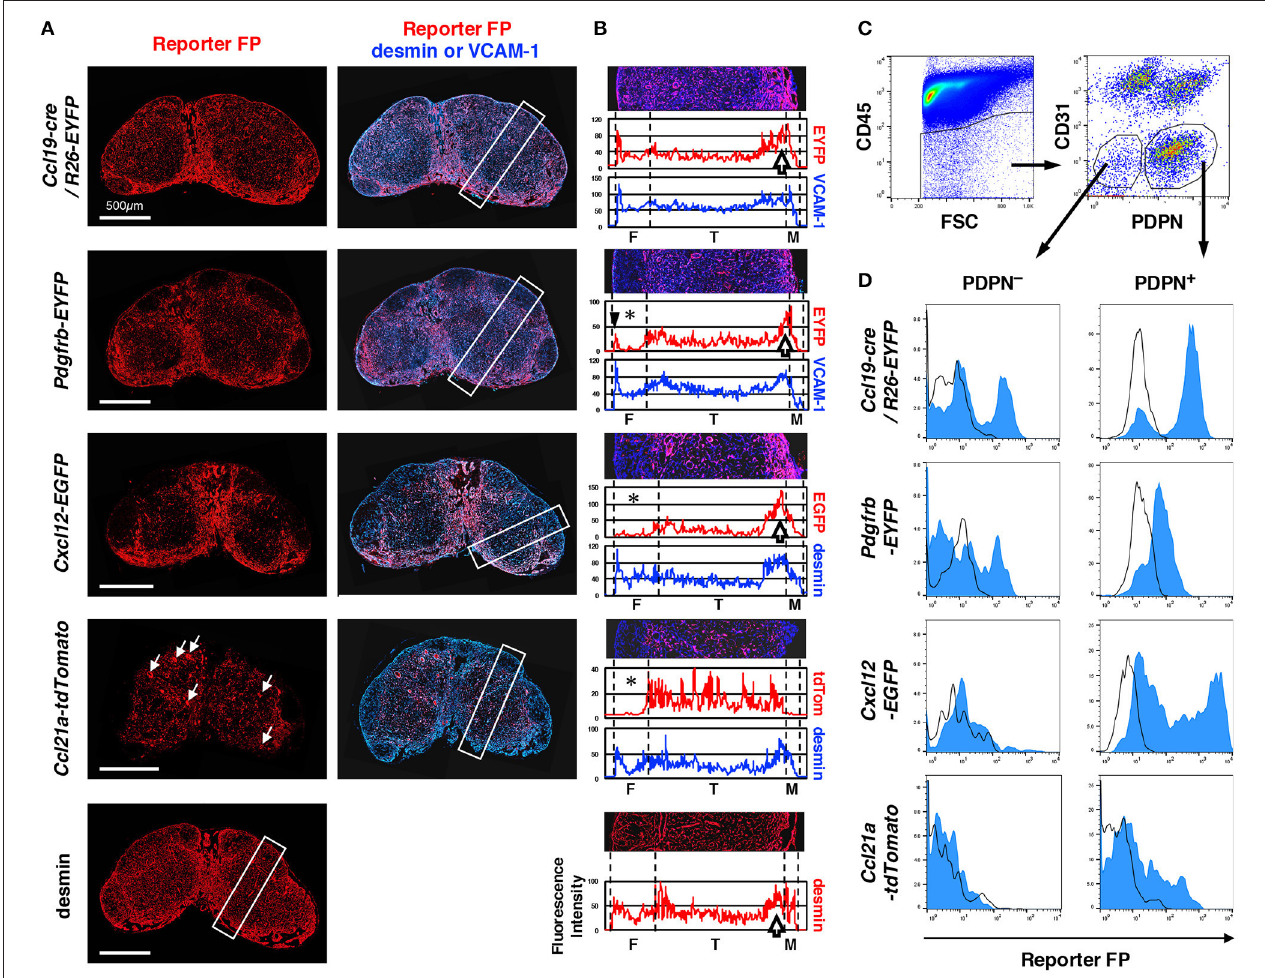
FIGURE 1 | Differences in LN stromal structural patterns based on gene reporters. (A) Whole views of inguinal LNs isolated from various reporter mice. Vertical sections of LNs were stained with antibodies against fluorescent protein (FP) and desmin or VCAM-1. White arrows in the panel of Ccl21a -tdTomato indicate HEVs. (B) Average fluorescent intensity profiles of the rectangular boxed region along with the cortex-medulla axis in (A) . The image of the region of interest (ROI) is replicated in the upper part and the boundary between subcompartments is indicated by dotted lines. Note the absence of or low FP expression in the follicular area (asterisks), the sharp peak in FP in the outer margin of the follicle (arrowhead in Pdgfrb -EYFP), and the higher signal around the boundary of the T cell area and medulla (open arrows). F, follicle; T, T cell area (paracortex); and M, medulla. (C) Flow cytometric analysis of FSCs. CD45 − LN cells (left) were further fractionated by CD31 and PDPN expression (right), and the CD31 − non-endothelial fraction was defined as FSCs including PDPN + conventional fibroblastic reticular cells (FRCs) and PDPN − cells (gated, respectively). (D) FP expression in PDPN + and PDPN − cells. Open histograms show the corresponding cell fraction of wild type